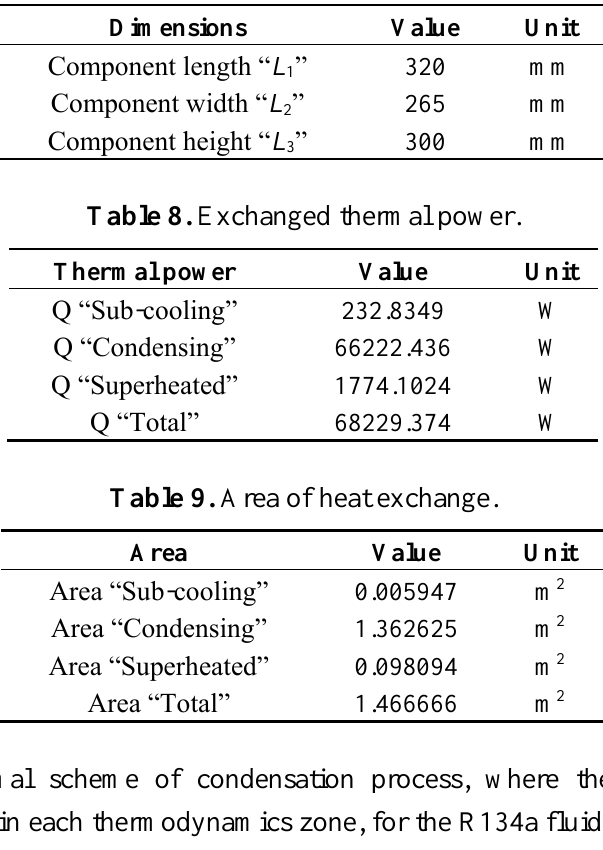
Table 7. Main dimensions of R134a component.